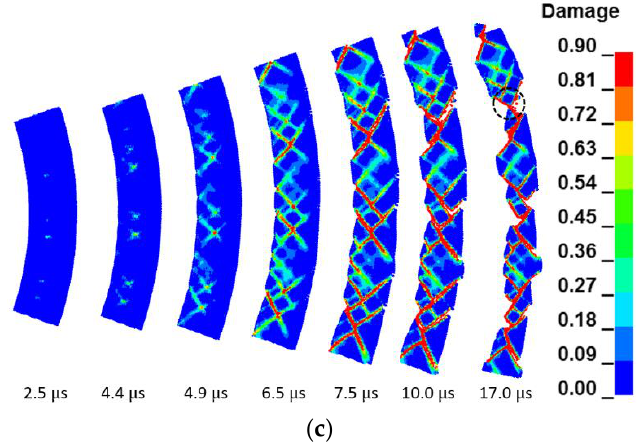
Figure 9. The explosive pressure, expanding deformation, and fracture for 45 steel cylinder shell under JOB9003 loading: ( a ) detonation wave propagation curves; ( b ) development of effective plastic strain in the shell thickness; ( c ) damage evolution for pure shear fracture.